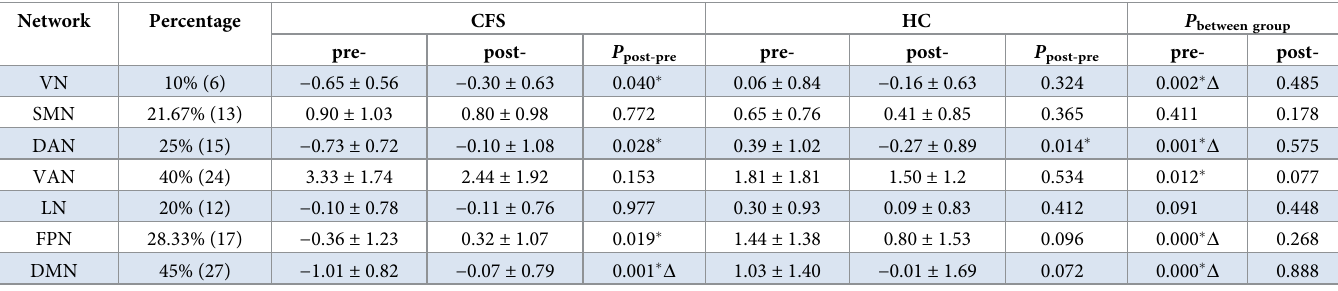
Table 3. Network comparison of features (mean ±